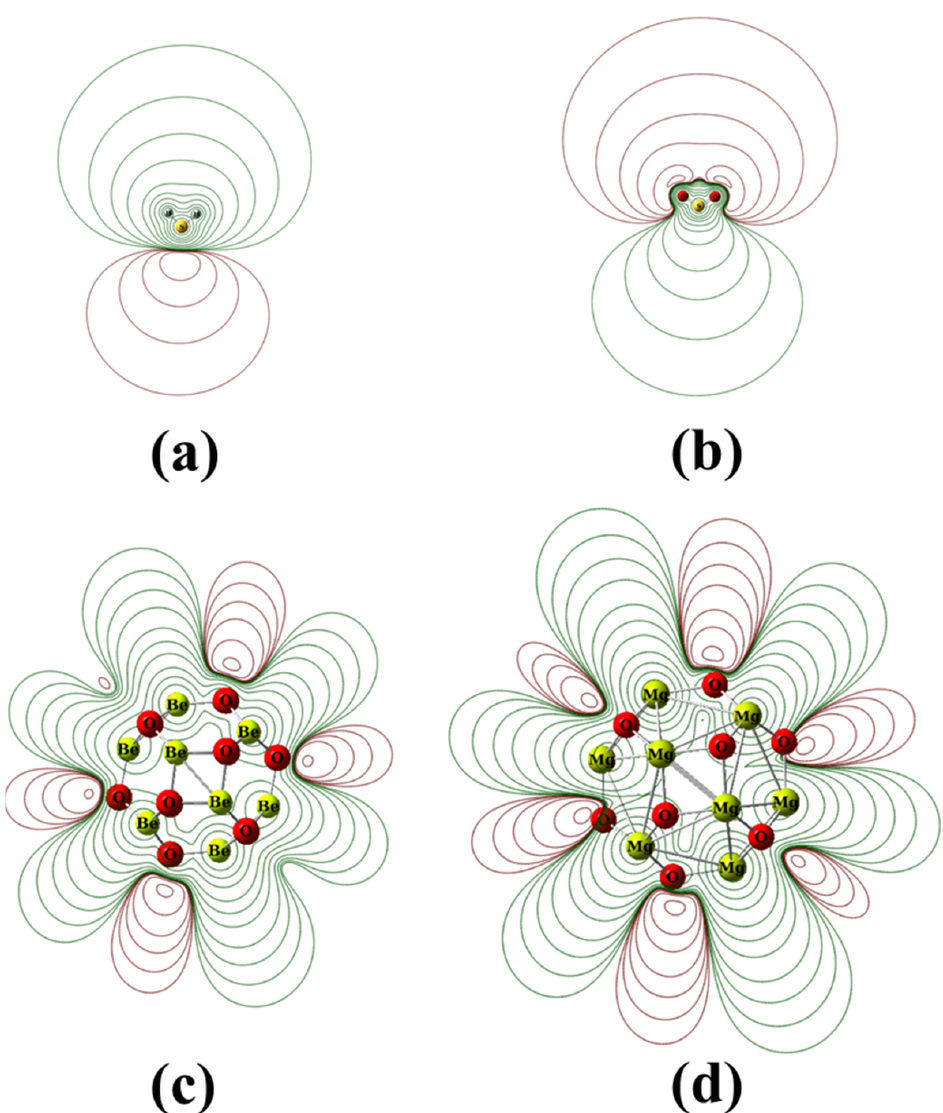
Figure 2. The molecular electrostatic potential contours (MESP) for ( a ) free H 2 S gas, ( b ) free SO 2 gas, ( c ) Be 12 O 12, and ( d ) Mg 12 O 12 nano-cages at ±0.001, ±0.002, ±0.004,…. , ±0.8 au iso-values. Red and green colors are assigned to negative and positive values, respectively.